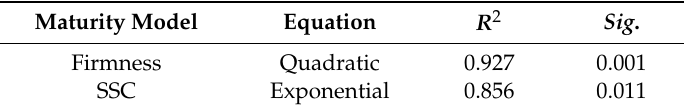
Table 2. Curve regression analysis for tomato maturity and